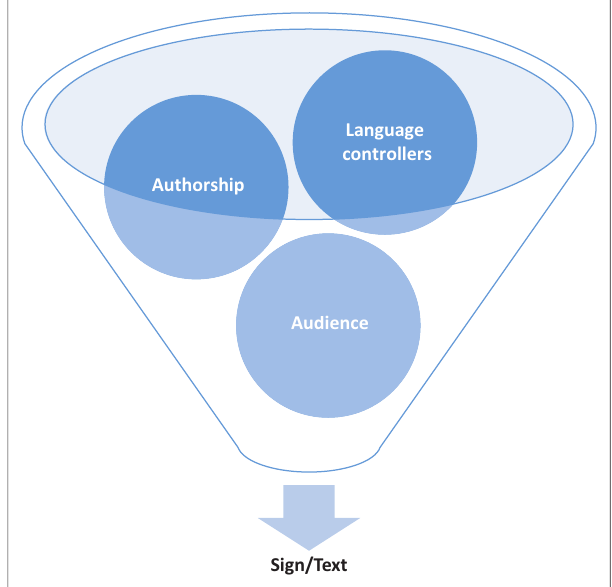
FIGURE 3: A graphic representation of the symbiotic relationship between sign producers and consumers.